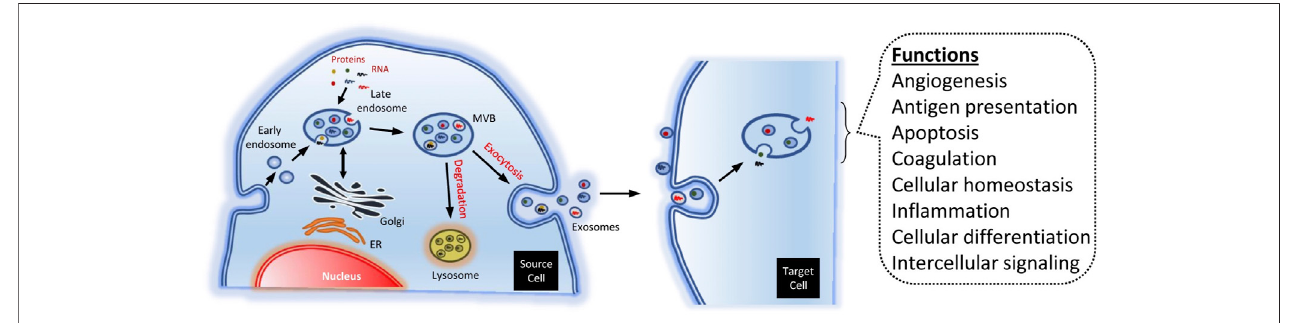
FIGURE 1 | Biogenesis and function of exosomes (Casado-Díaz et al., 2020).